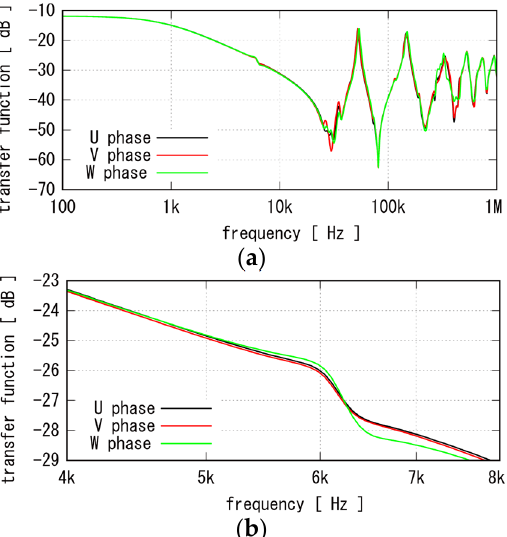
Figure 10. Measured TFs in IIW measurement of Tr-A5 from ( a ) 100 Hz to 1 MHz and ( b ) enlargement of RBS [35].